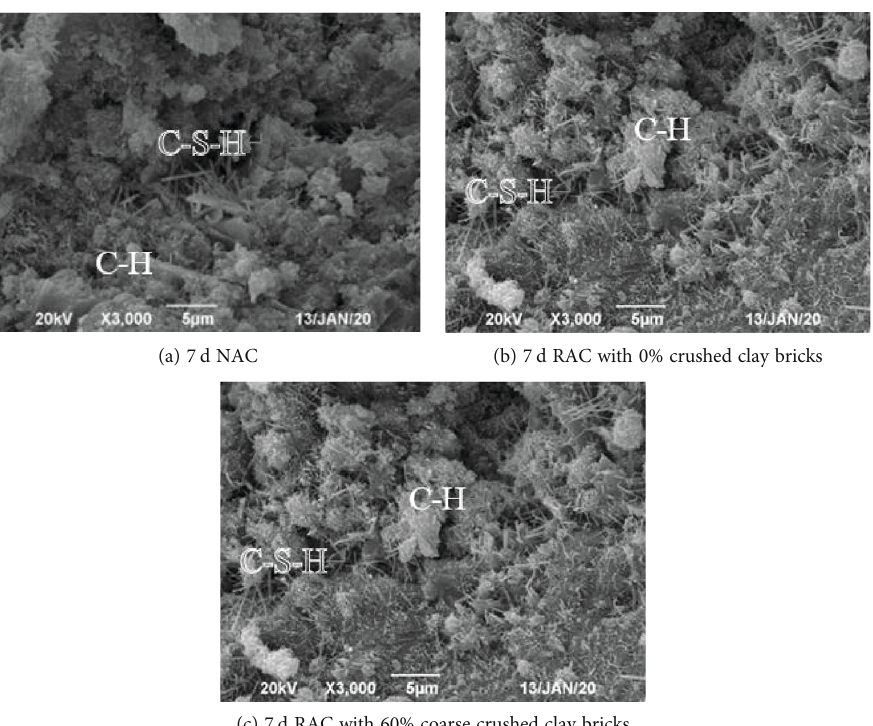
Figure 8: Microscopic morphology of NAC and RAC with 0% or 60% coarse crushed clay bricks at the age of 7d (magni fi ed 3000